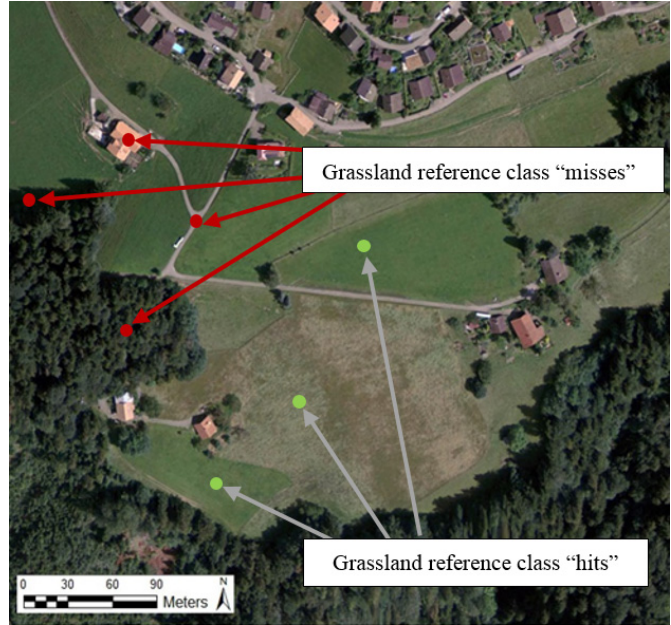
Figure 4. Original non-standard class-specific simple random sampling (SIRS) strategy for the reference class “ grassland ”, using a set of random spatial locations (sample candidates), whose selected spatial unit is pixel , see Table 7. Green random locations (selected as “hits”) are included in the “grassland” class-specific reference sample set, while red points (recognized as “misses”) are